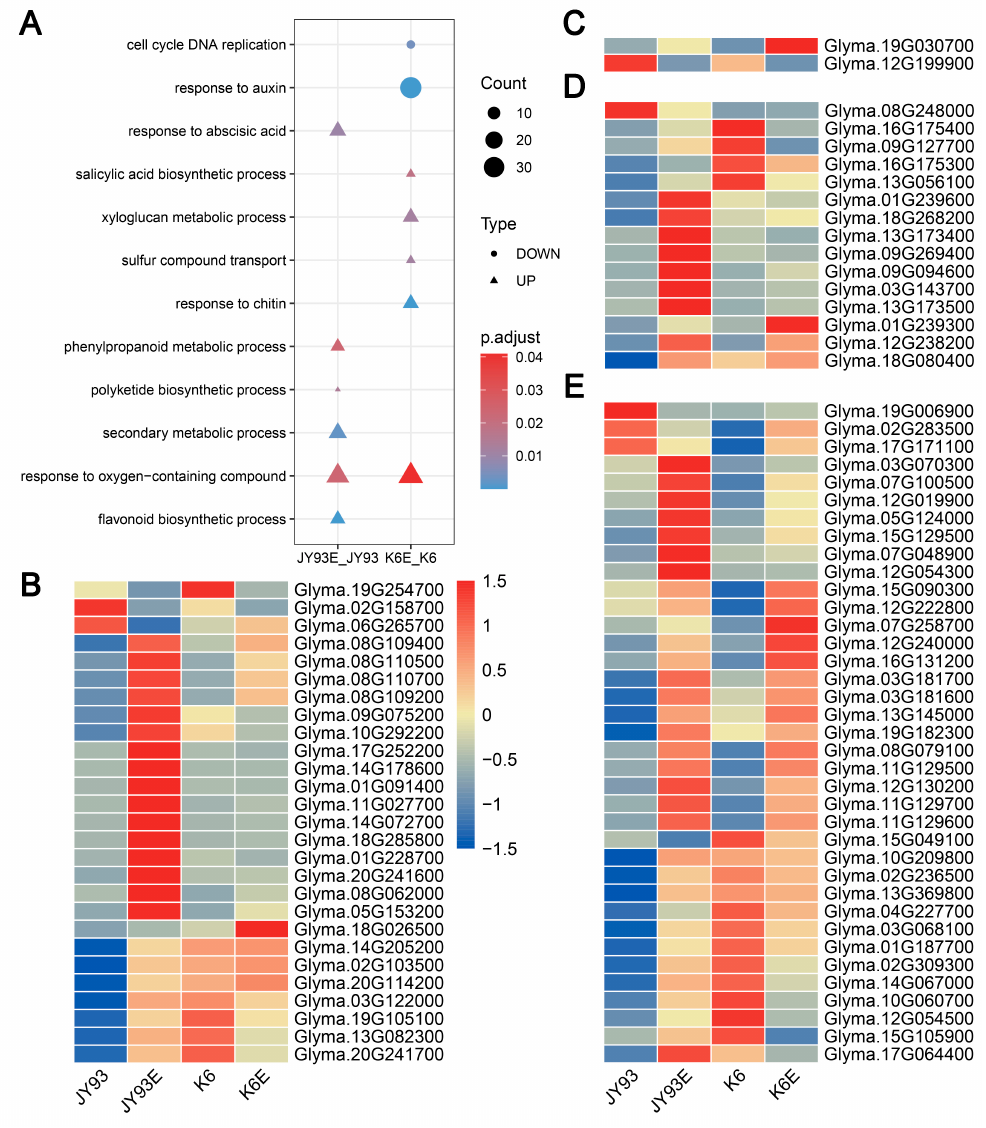
Figure 4. DRGs between mapping parents JY93 and K6. ( A ) GO enrichment analysis of DRGs. Three legends on right side show, from top to bottom, number of enriched genes (larger shape indicates greater number), type of gene response (circles indicate suppressed expression and triangles indicate upregulated expression after feeding by SPB), and significantly enriched level of entries (redder color indicates higher significance). ( B – E ) Expression levels of flavonoid metabolism-related genes: flavonoid metabolism, flavone and flavanol metabolism, isoflavonoid metabolism, and phenylpropanoid metabolism, respectively. Color bar on right side indicates expression levels of certain genes by Z-score method; red is high expression, blue is low expression.